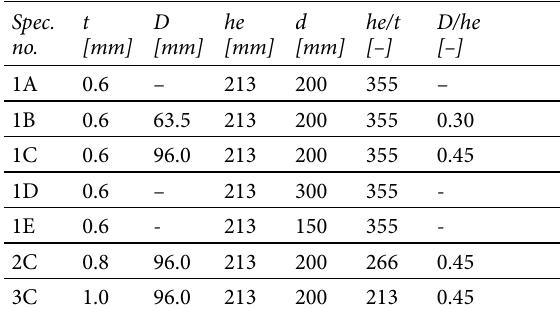
Table 1. Geometrical characteristics of the specimens Spec.